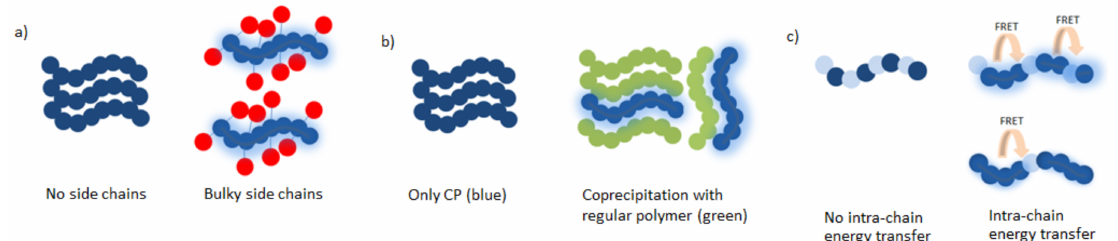
Figure 4. Different approaches to improve the photoluminescence quantum yield of conjugated polymer nanoparticles: ( a ) The use of bulky side chains; ( b ) the introduction of regular, non-conjugated polymers; and ( c ) varying monomer